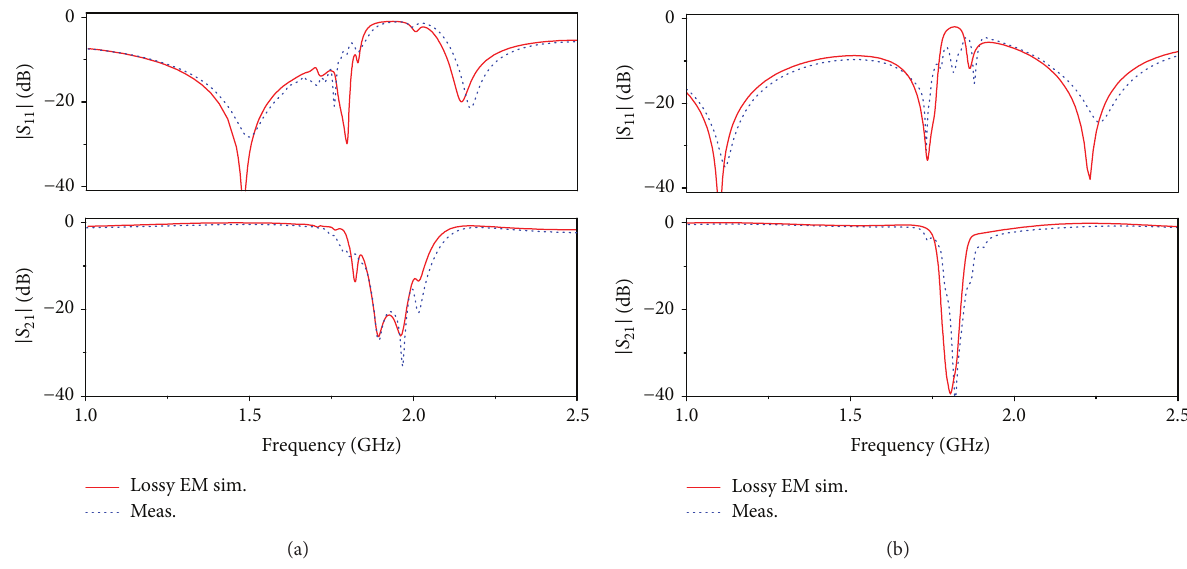
Figure 9: Measurement and lossy electromagnetic simulation of the transmission and reflection coefficients of the structures in Figure 7; (a) 𝑙 = 3 mm and (b) 𝑙 = 4.8 mm. The loss tangent in Rogers RO3010 is tan 𝛿 = 0.0023 . From [34], reprinted with permission.